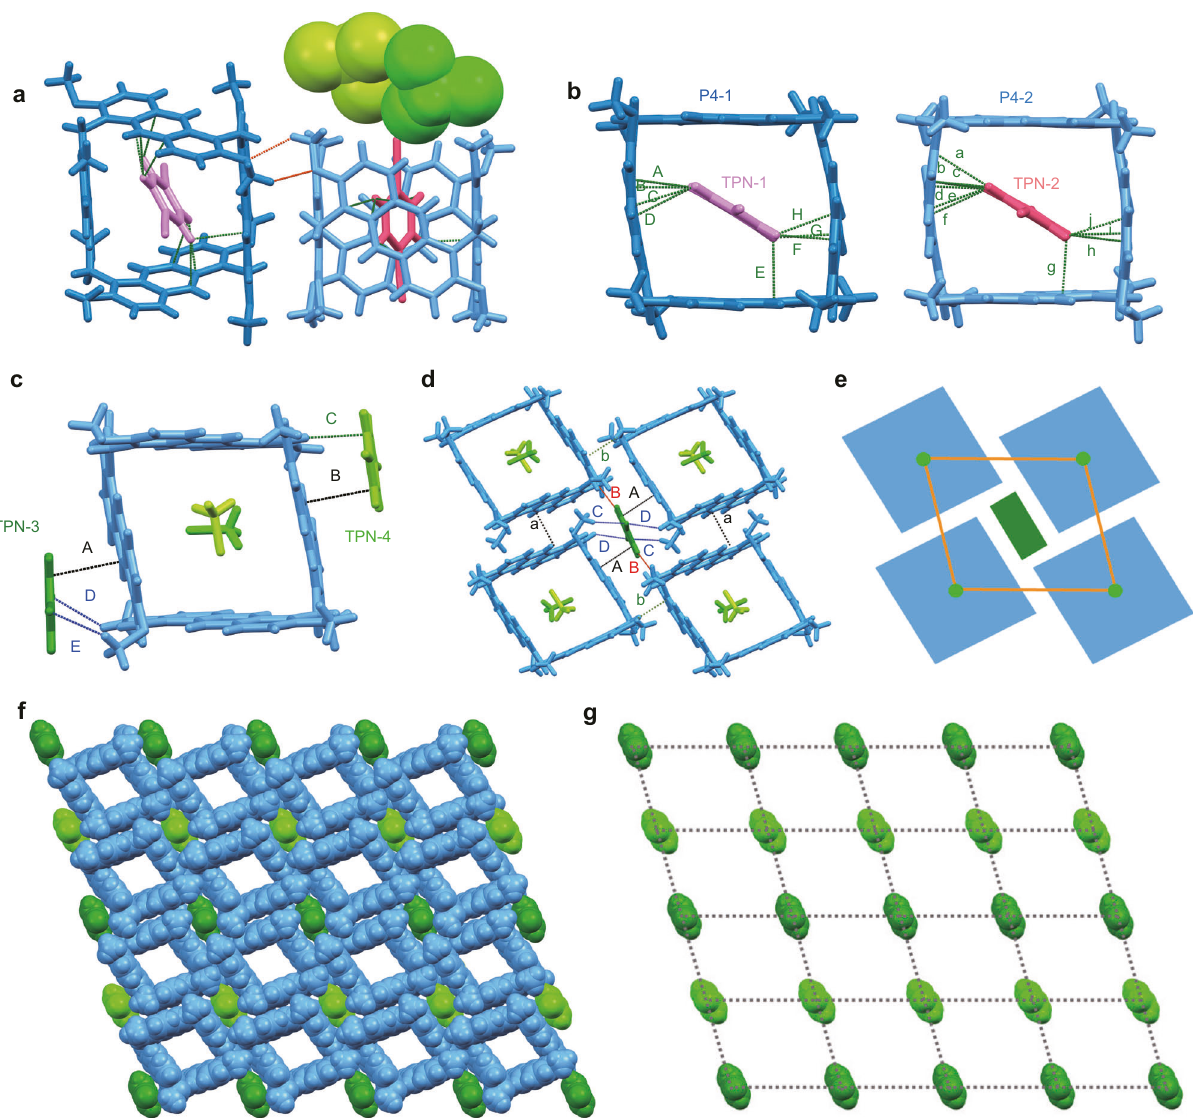
Fig. 6 Supramolecular tessellations of P4 with TPN. Crystal structure of P4-TPN a showing a the asymmetric unit; b the interactions between P4 and TPN. Crystal structure of P4-TPN b showing c the asymmetric unit; d interactions in the basic tiling unit; e schematic representation of the basic tiling unit; f two- dimensional tiling of the uniform superstructure formed by P4 and TPN in a plane; g regular parallelogram grids formed by TPN molecules. Different colors represent the symmetry equivalence. Green, black, and red dotted lines represent the noncovalent interactions. Crystallographically independent P4 and TPN molecules were marked as P4-1, P4-2, TPN-1, TPN-2, TPN-3, and TPN-4,